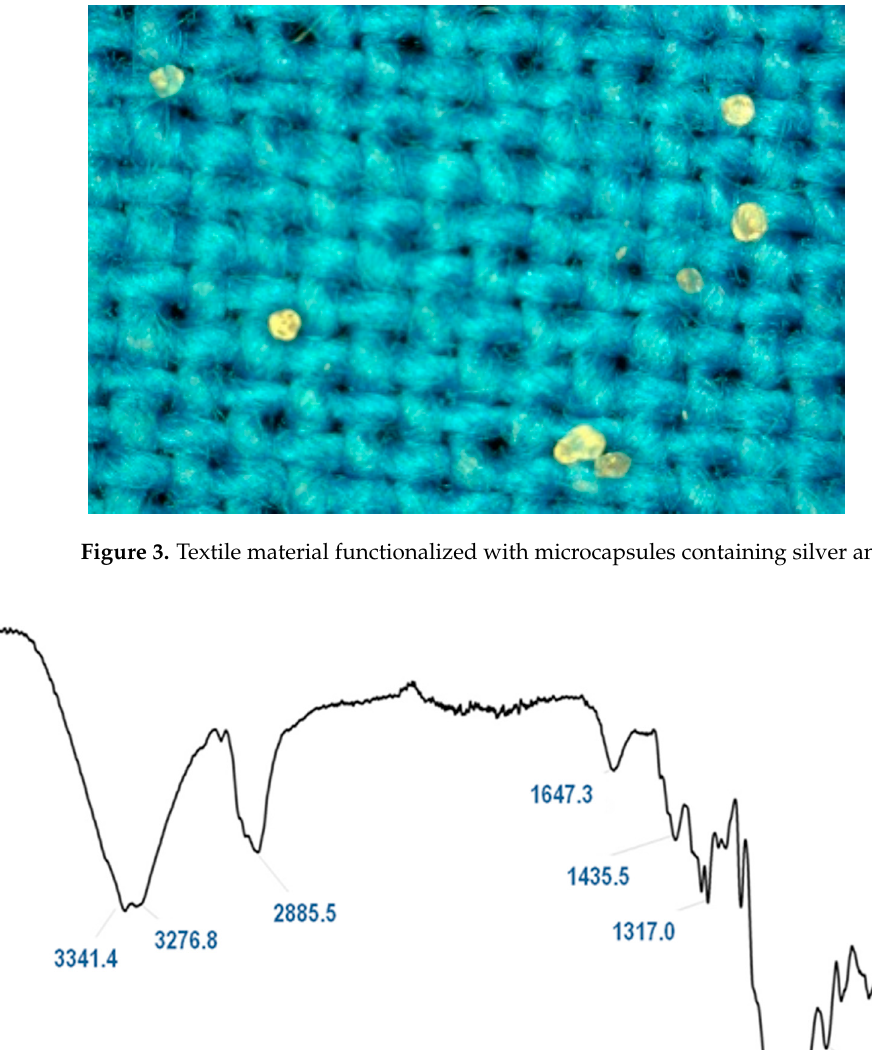
Figure 3. Textile material functionalized with microcapsules containing silver and zinc.